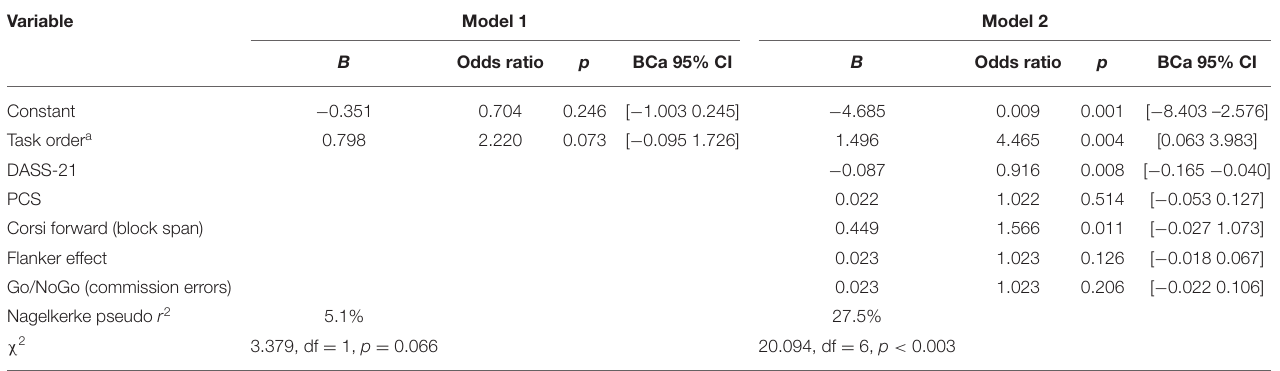
TABLE 3 | Hierarchical binary logistic regression model.